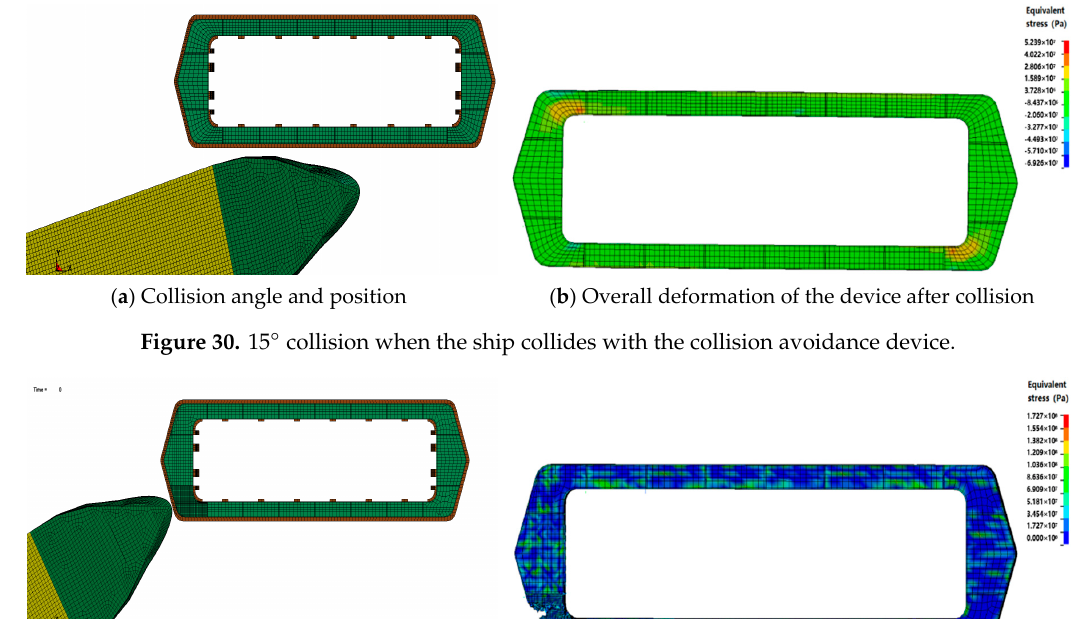
Figure 29. 0° collision when the ship collides with the collision avoidance device.